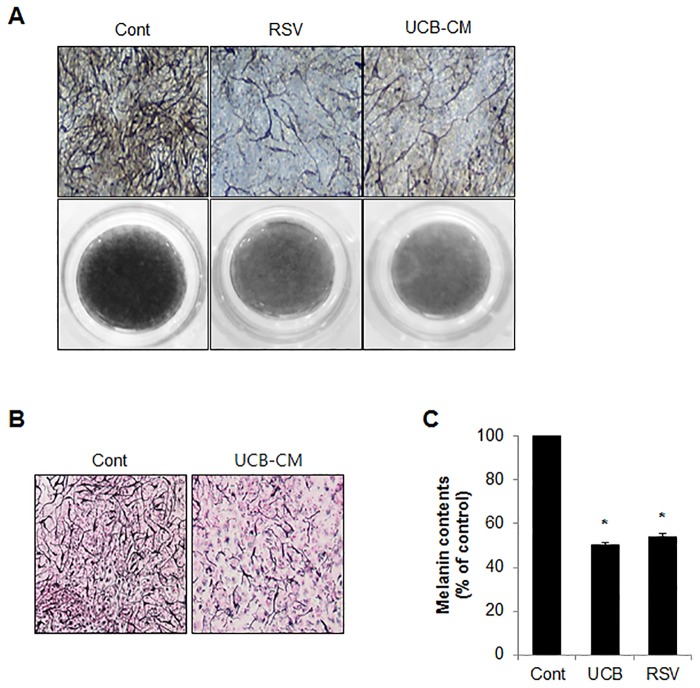
hUCB-MSC-CM suppresses melanogenesis in an artificial human skin model.(A-C) MelanoDerm tissues were incubated with either growth medium (Cont) or hUCB-MSC-CM for 20 days or resveratrol (RSV) for 18 days. Then the Melanoderm tissues were observed under a microscope (A) or analyzed by Masson-Fontana staining (B). The tissues were collected to determine the total melanin content (C). RSV was used as a positive control agent. Data represent standard error of the mean (S.E.M) from three independent experiments (n = 3, p<0.05)